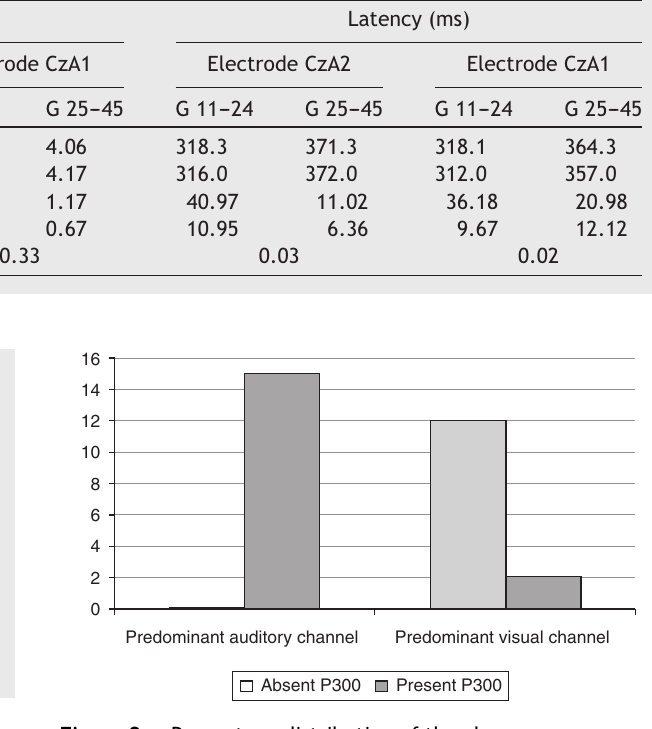
Percentage distribution of the absence or presence of P300 according to the variable predominant communication channel (auditory or